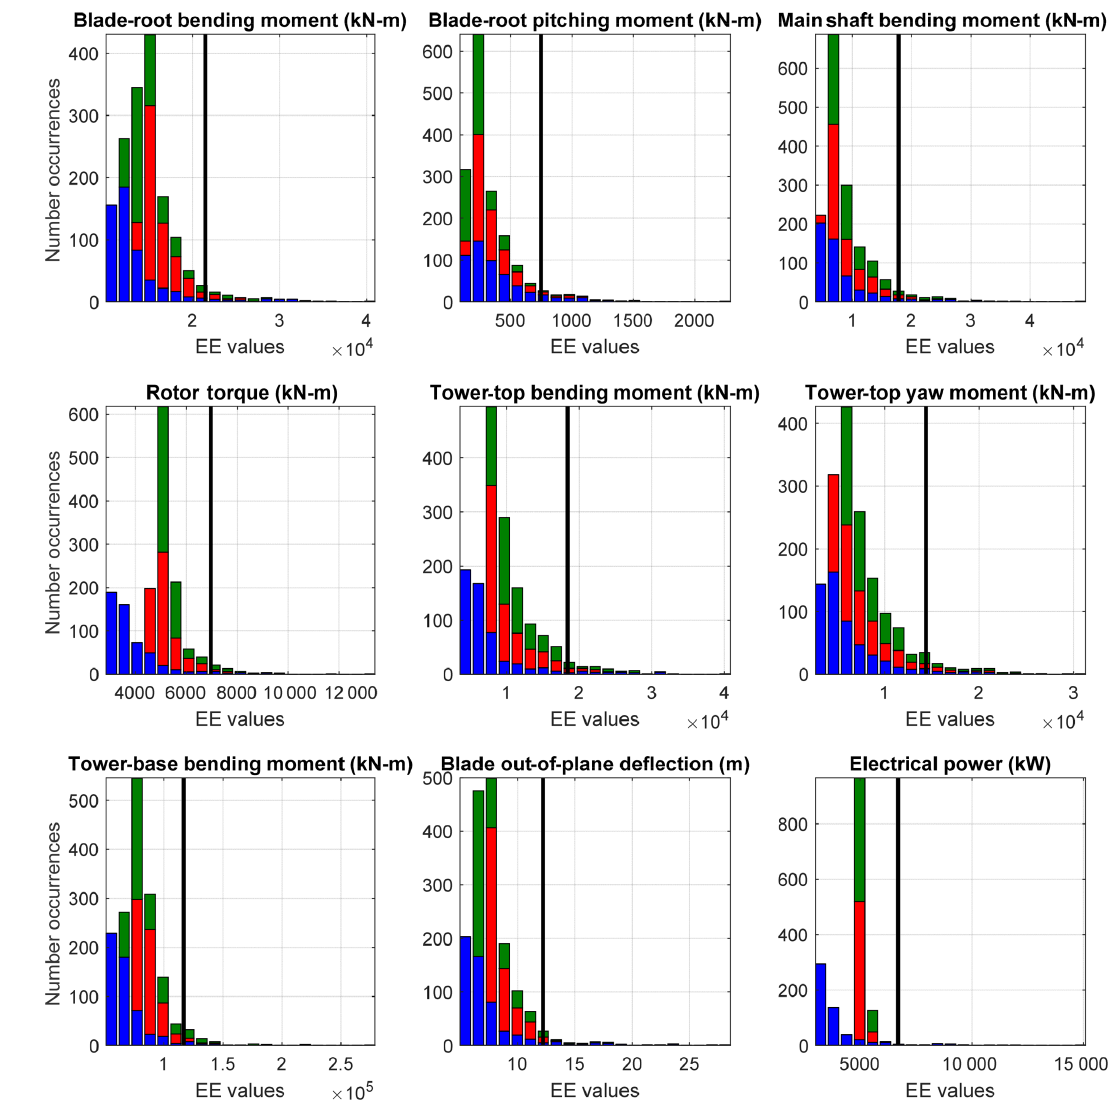
Figure 4. Stacked histogram of the ultimate load EE values for each of the QoIs across all wind speed bins, input parameters, and simulation points. Black line represents the defined threshold by which outliers are counted for each QoI. Color indicates wind speed bin (blue is below-rated speed, red is near-rated speed, green is above-rated speed).